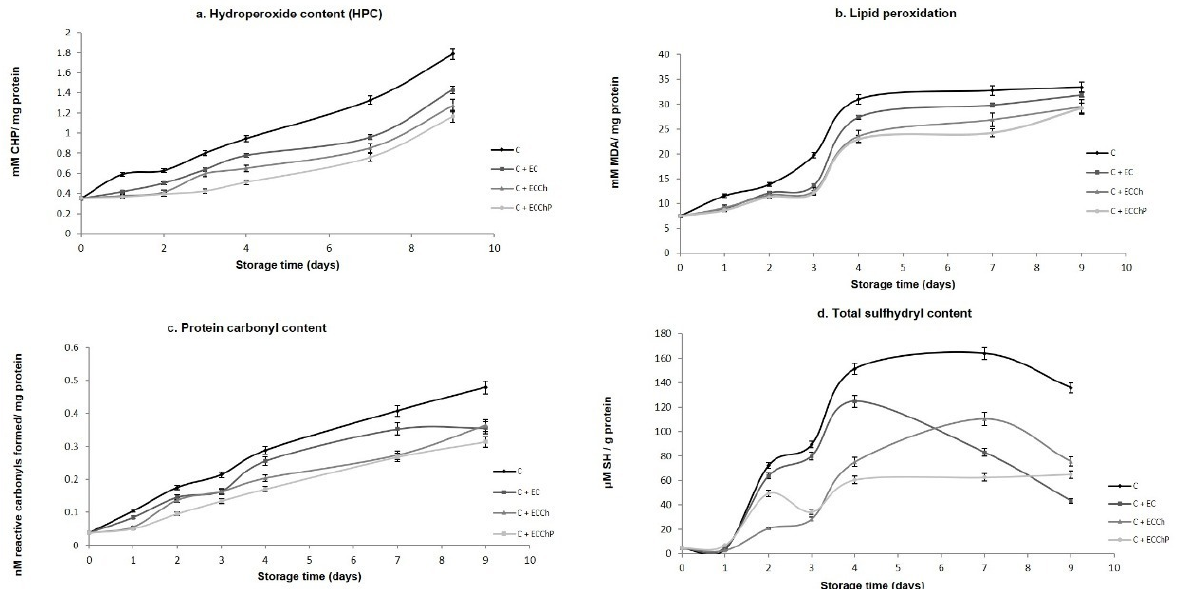
Figure 5. Changes in formation of oxidation products in common carp (Cyprinus carpio) fillets stored at 4 °C for nine days. Values are the mean of three replicates. C = uncoated fillet (control); C + EC = carp fillet with edible coating; C + ECCh = carp fillet with chitosan-based coating; C + ECChP = carp fillet with chitosan-based coating enriched with peppermint extract; MDA = malondialdehyde; CHP = cumene hydroperoxide; -SH = sulfhydryl.